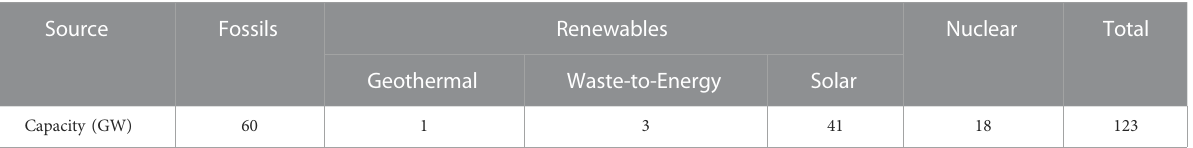
TABLE 1 The 2032-proposed electricity supply mix by KA-CARE